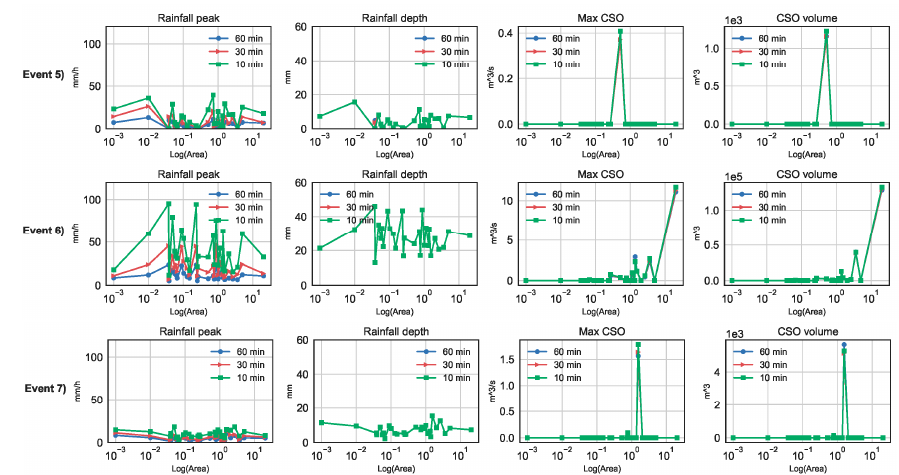
Figure 7. By-catchment response to rainfall temporal accumulation for the ARadar spatial product (catchments are represented on the x axis by their connected area in km 2 ).